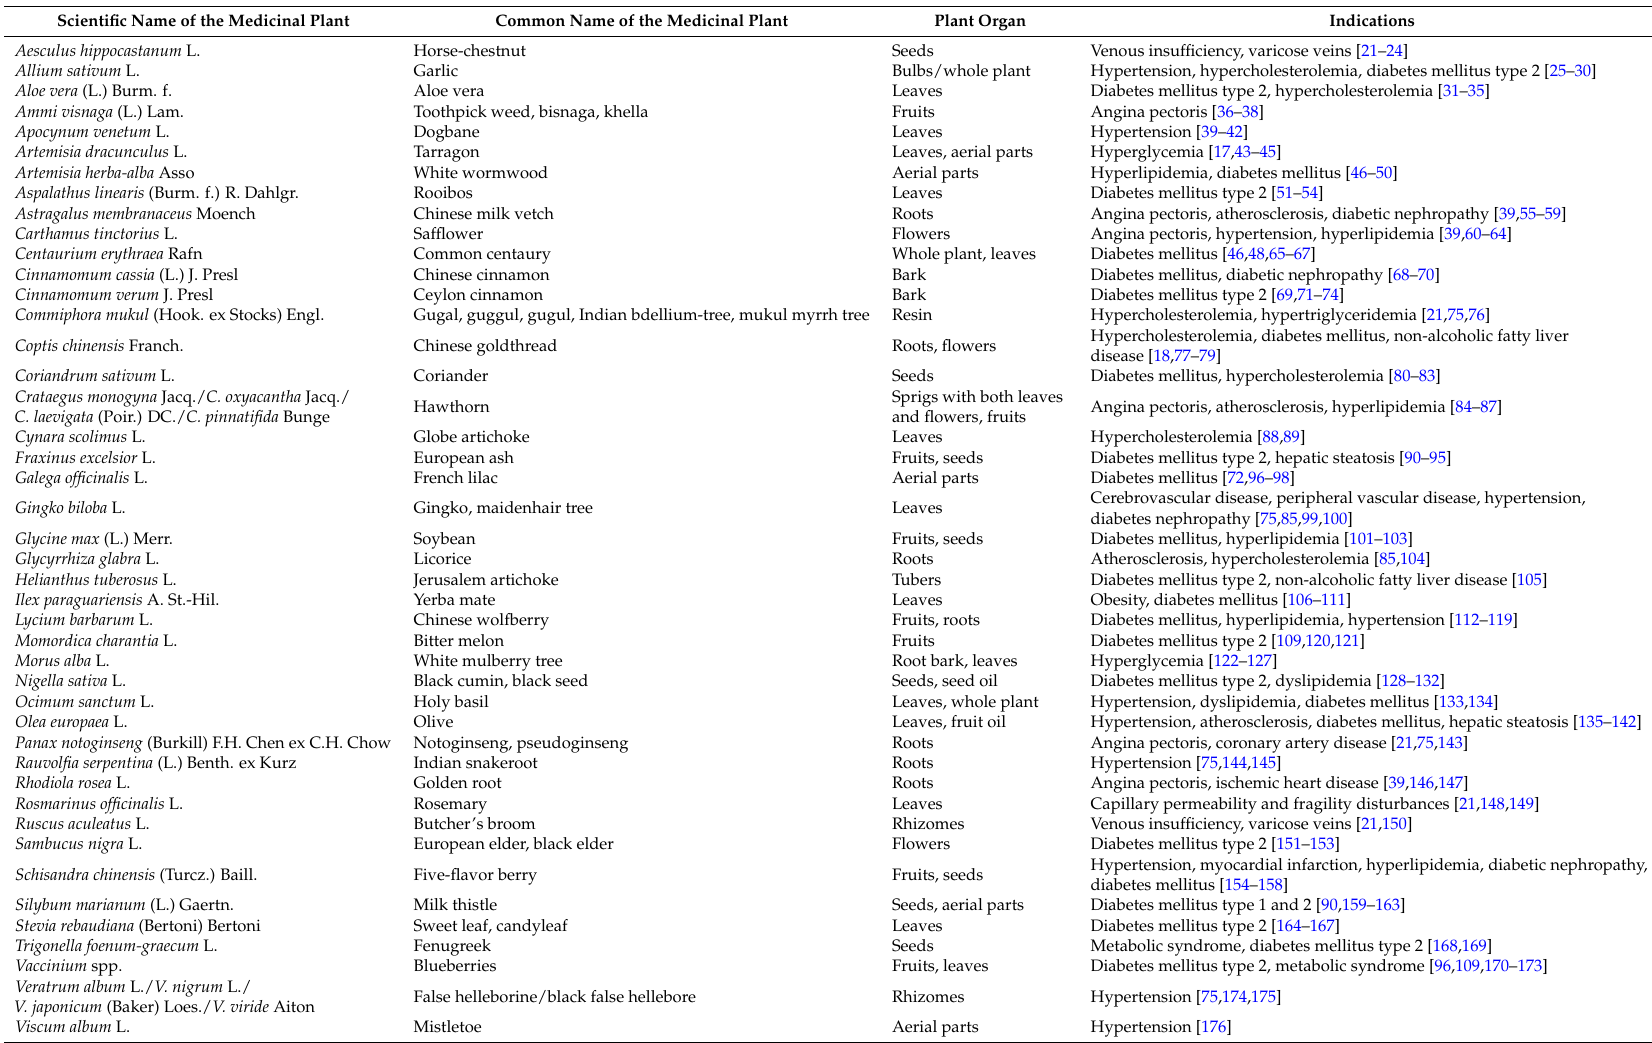
Table 1. Medicinal plants targeting indications related to cardiovascular or metabolic